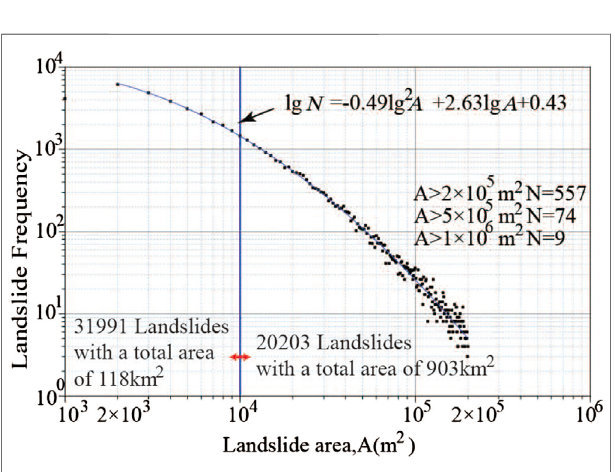
FIGURE 8 | Relationship between the cumulative number and area of landslides in the Wenchuan earthquake (Du et al., 2020a).